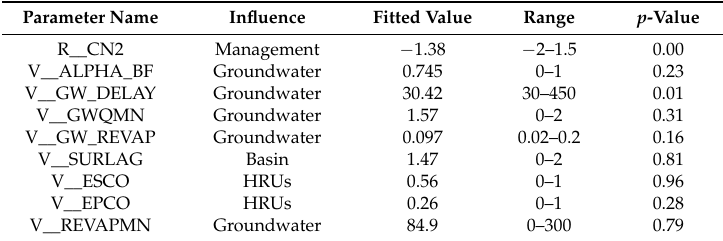
Table 3. Sensitivity analysis for the SWAT model with